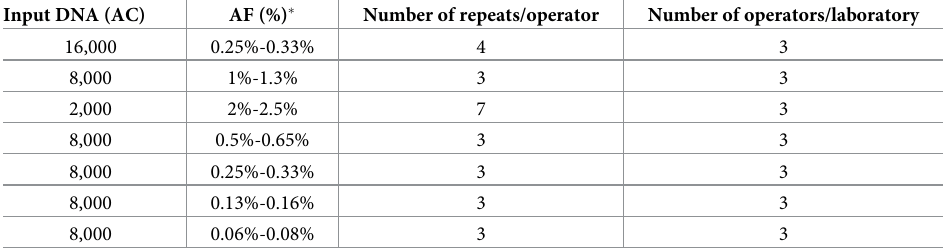
Table 1. Details of analytical validation experiments performed to assess sensitivity of the eTAm-Seq technology, including range of input DNA (AC), AF (%), number of sample repeats per operator, and number of operators per